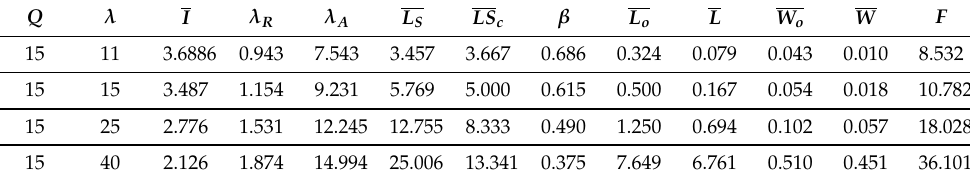
Table 2. The effect of λ on performance measures at Q = 15.